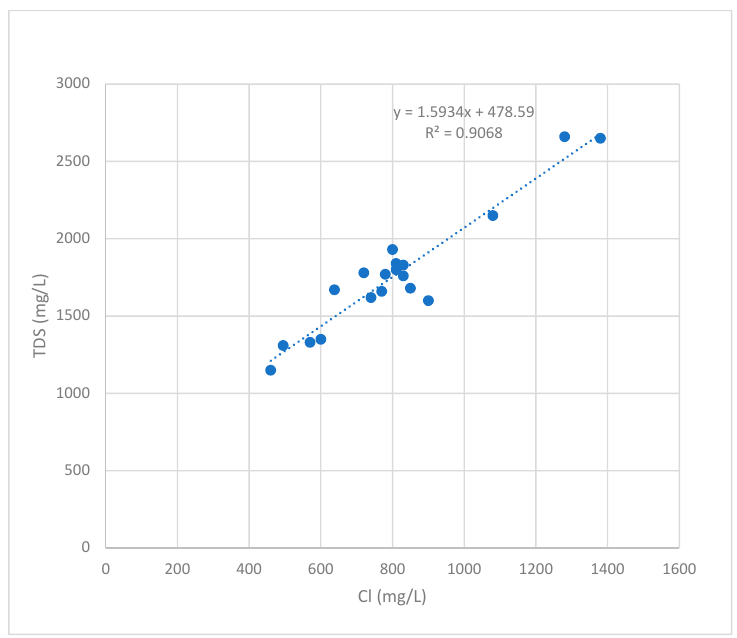
Figure 12. Cross plot of the dissolved chloride concentration versus the TDS taken from chemical analyses of production well water samples from the Lower Hawthorn Aquifer [42].